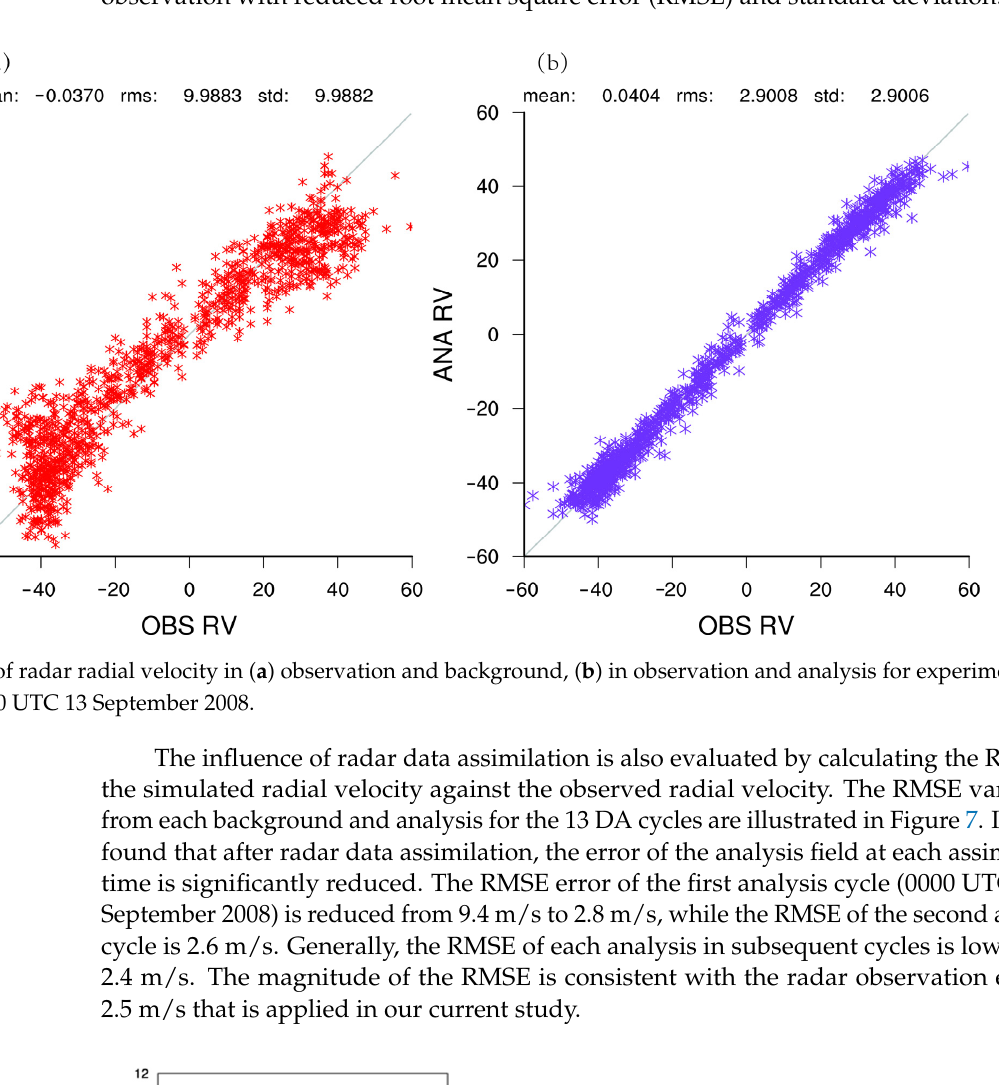
Figure 5. The 700 hPa wind analysis increments (m/s) at 0000 UTC 13 Sep 2008 from experiment DA_Radar.